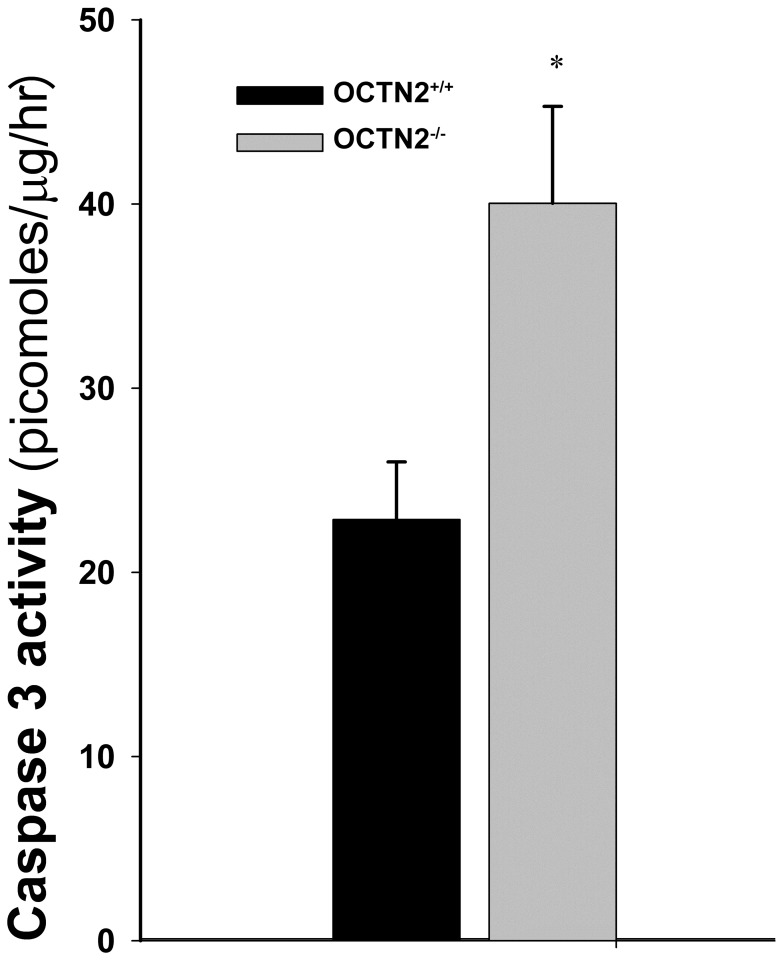
Caspase 3 activity in 1-week old small intestine mucosal scrapings from OCTN2+/+ (black bar) and OCTN2−/− mice (white bar).Asterisk (*) represents statistically significant difference in activity.